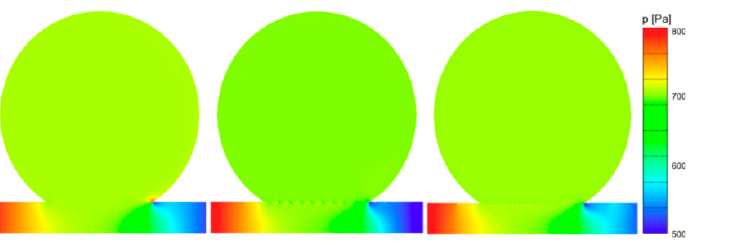
Figure 10. Pressure contour at the mid plane of the UA ( left ), the RS ( center ), and FD ( right ) at peak systole.